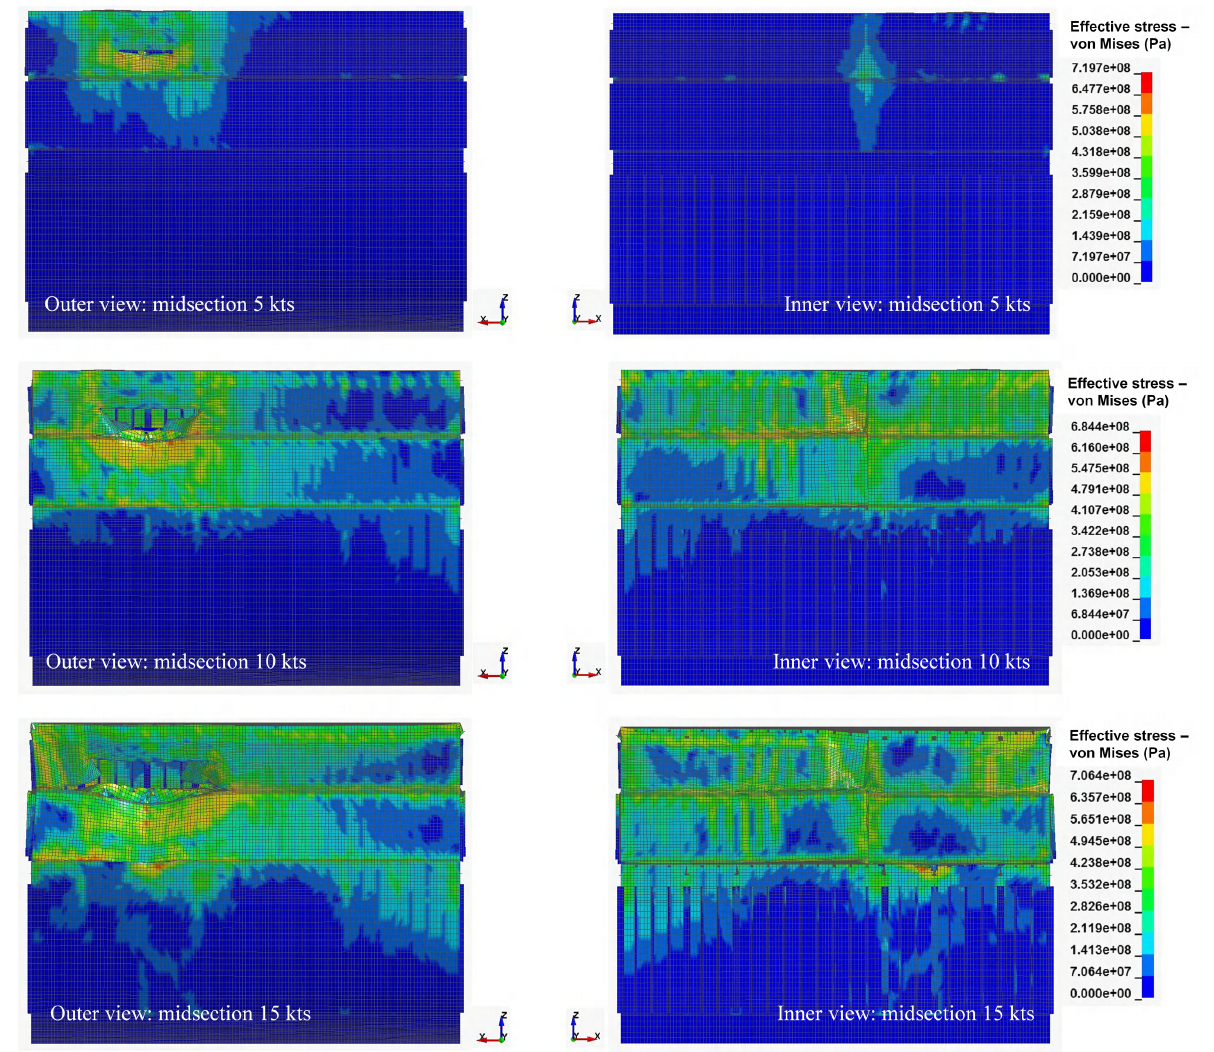
Figure 15: Damage extent and stress contours on the midsection impacted by the selected striking